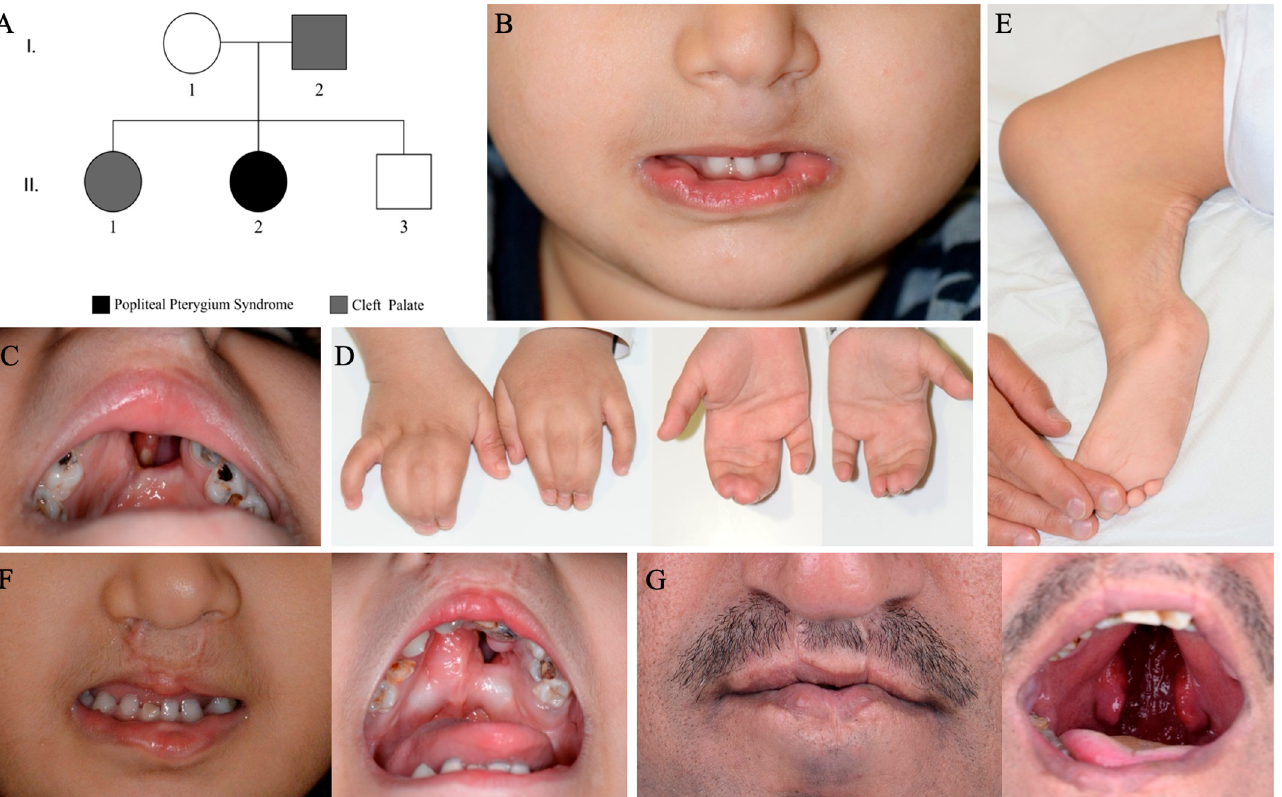
Figure 1. Family pedigree and clinical phenotypes in proband and affected family members. ( A ) Pedigree of family members shows the proband (II-2) with popliteal pterygium syndrome (PPS), father (I-2) and sister (II-1) with van der woude syndrome (VWS); ( B ) Proband with repaired bilateral cleft lip and lower lip pits and cysts on both sides; ( C ) Proband with cleft palate; ( D ) Proband with bilateral complete, simple syndactyly of second and third webspace of the hands; ( E ) Proband with right popliteal pterygium; ( F ) Sister with repaired bilateral cleft lip and palate and lower lip pits and cysts on both sides; ( G ) Father with repaired bilateral cleft lip, unrepaired cleft of the entire secondary palate, and lower lip pits and cysts.